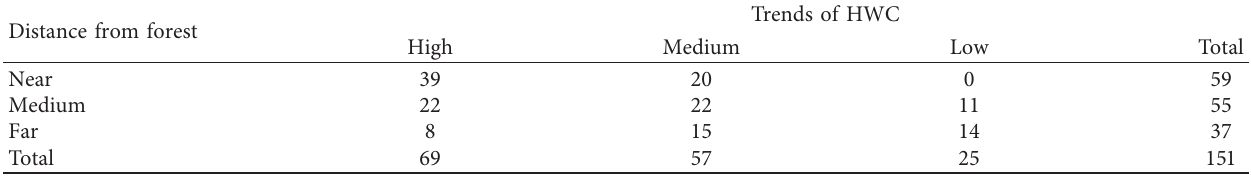
Table 4: Response rate on approximate distance from the forest and trends of HWC in the last three